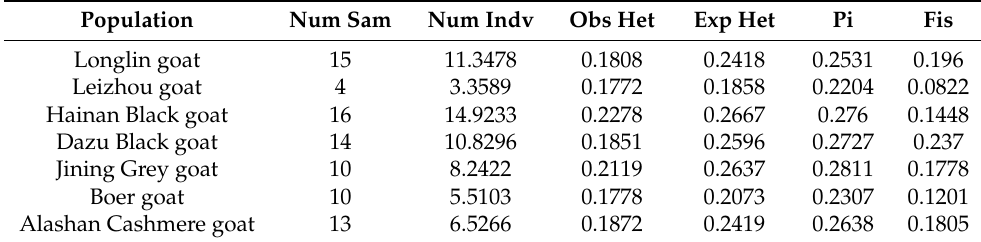
Table 2. Statistical results of the genetic diversity of each population.